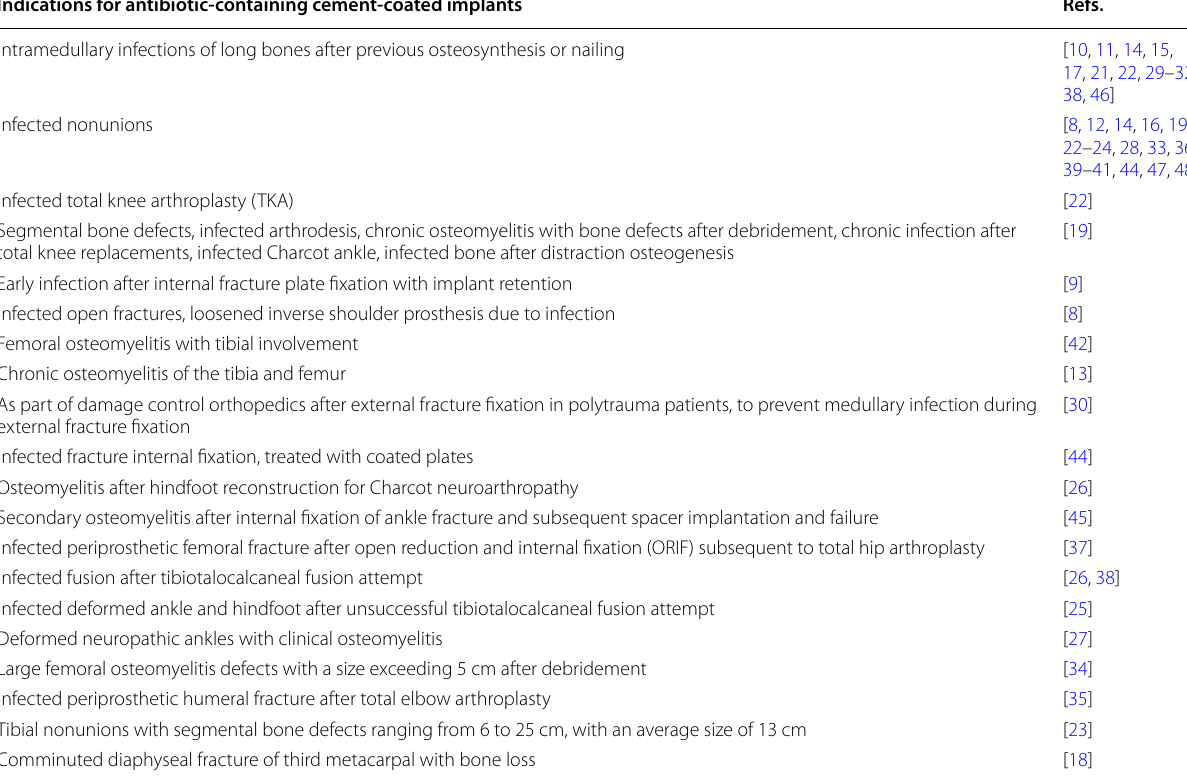
Table 2 Indications for antibiotic-containing cement-coated implants in different studies Indications for antibiotic-containing cement-coated implants